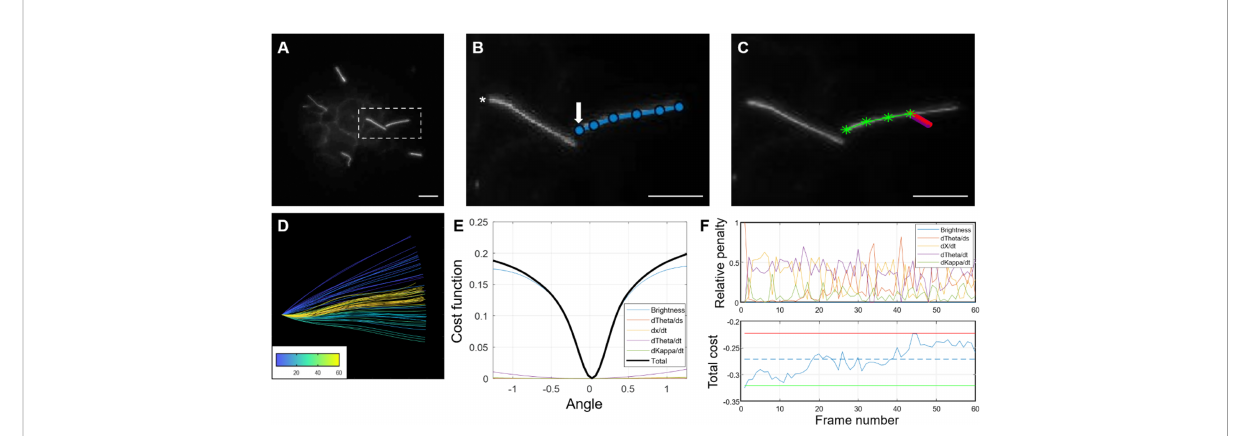
FIGURE 8 Step-by-step demonstration of MATLAB cilia waveform autotrace and quanti fi cation. (A) Grayscale image of a user-de fi ned frame from time- lapse video of ciliary motion, allowing manual selection of the cilium of interest and identi fi cation of a stationary cilia base as reference for tracing. (B) Magni fi ed inset showing user-de fi ned traces (blue line) from the ciliary base (arrow) to tip and another ciliary base (asterisk) not quanti fi ed in this example. Scale bars, 10 µm. (C) Automated cilia tracing by the program. Green line represents completed waveform traces by searching for regional maxima, and red represents a rotating rectangular array of points spanning the width and length of the fi rst cilium segment (D) Color-coded waveforms of the cilium in (C) corresponding to a temporal heatmap. (E) Dynamic cost function of waveform tracing. The angle chosen is the one that minimizes a linear combination of the (negative) weighted pixel intensity under the probe array as well as penalty terms used to improve robustness in cases of noise, poor contrast, and focus. (F) Example of the relative penalties and total cost for a 60-frame trace. For the total cost plot, the dashed line represents the mean cost, the upper (red) and lower (green) lines represent two standard deviations above and below the mean, respectively.